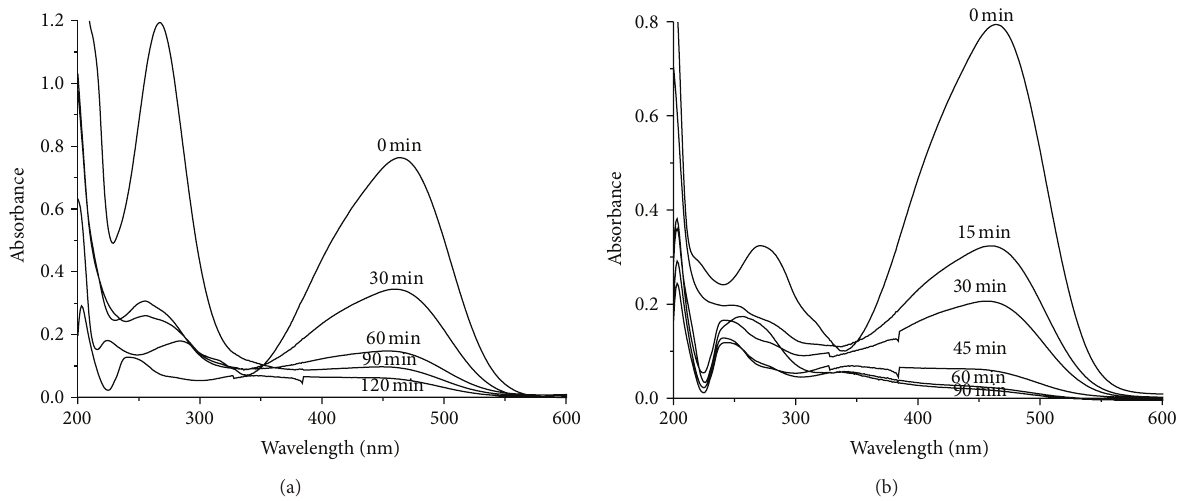
Figure 7: (a) Degradation of 10mg/L MO under sunlight over 3 g/L of 1.5%Au/TiO 2 . (b) Degradation of 10mg/L MO under UV irradiation over 3g/L of 2%Au/TiO 2 .